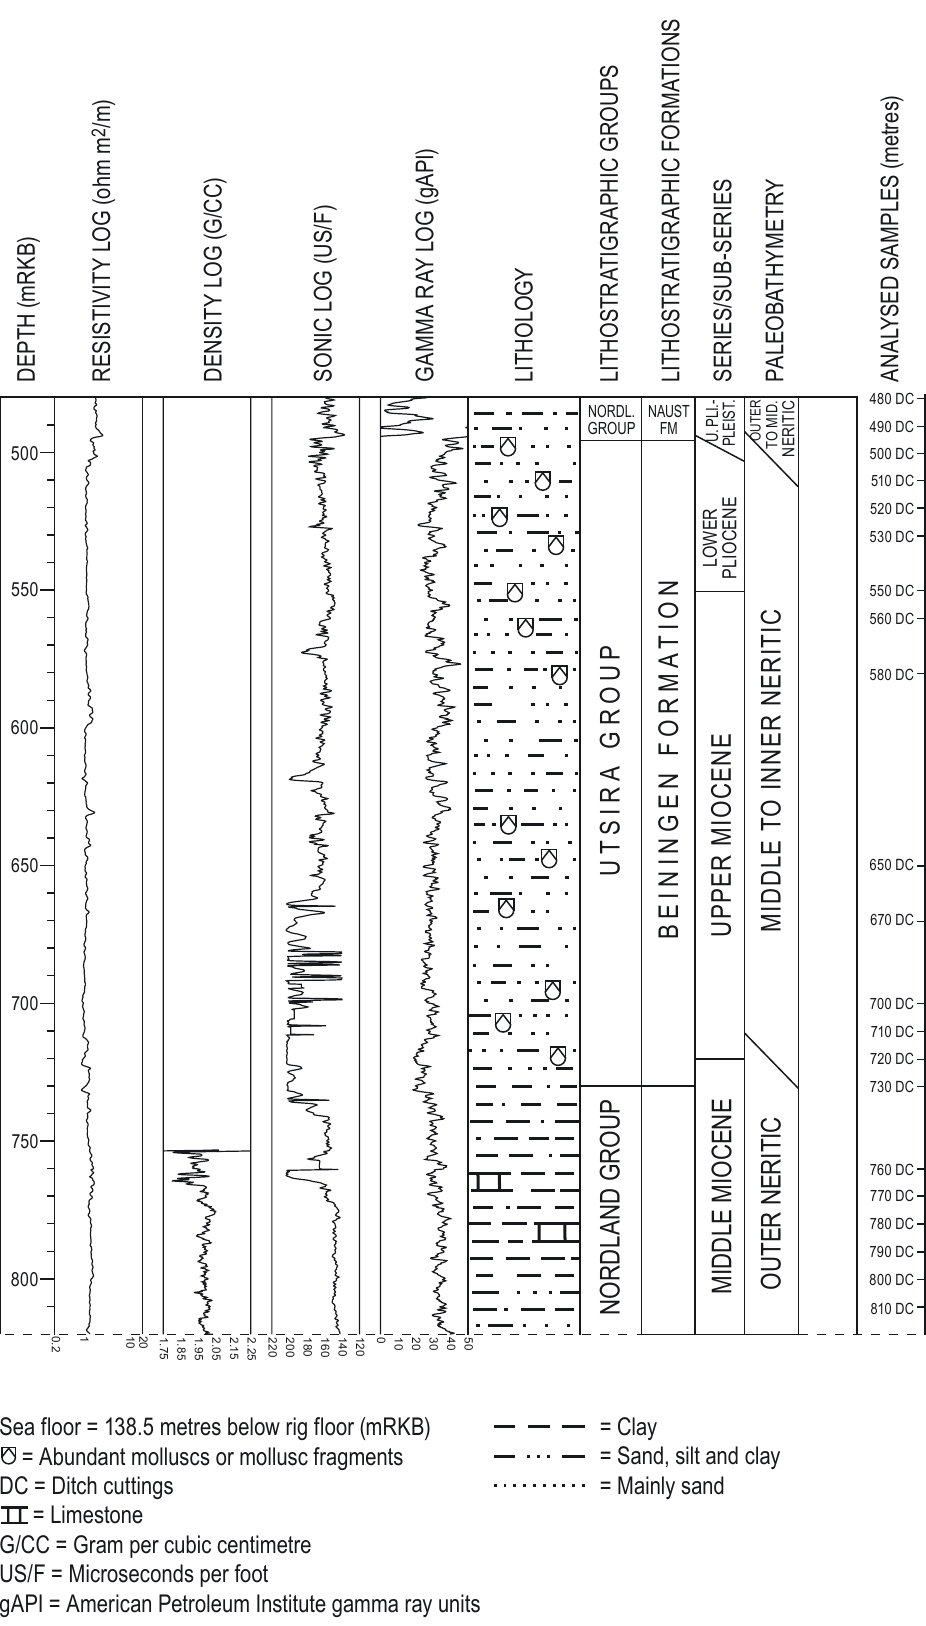
Figure 40. Well summary figure including resistivity log, density log, sonic log, gamma-ray log, lithology, litho- stratigraphic units, series/sub-series, stage, paleobathymetry and analysed samples for the upper part of the investigated sequence in well 24/12–1 (middle Miocene to upper Pliocene/Pleistocene) including the well type sections for the Beiningen Formation (modified after Eidvin & Rundberg, 2007; Eidvin et al.,